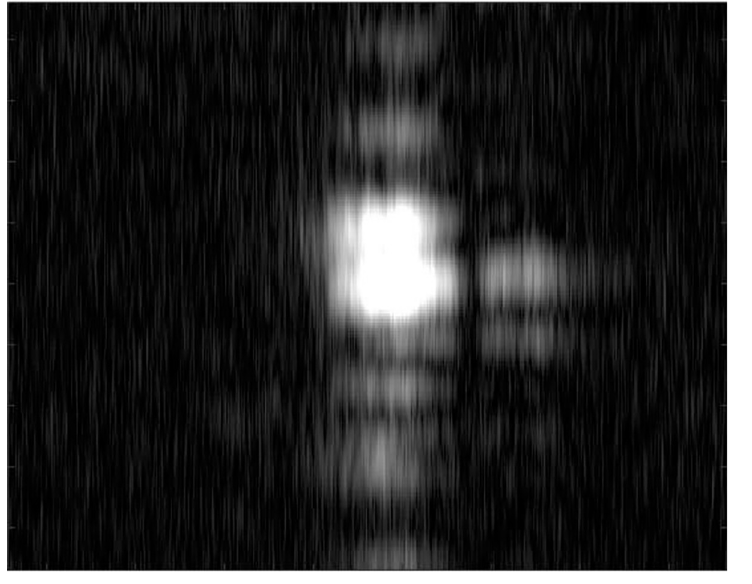
Fig 17. The real focused results.